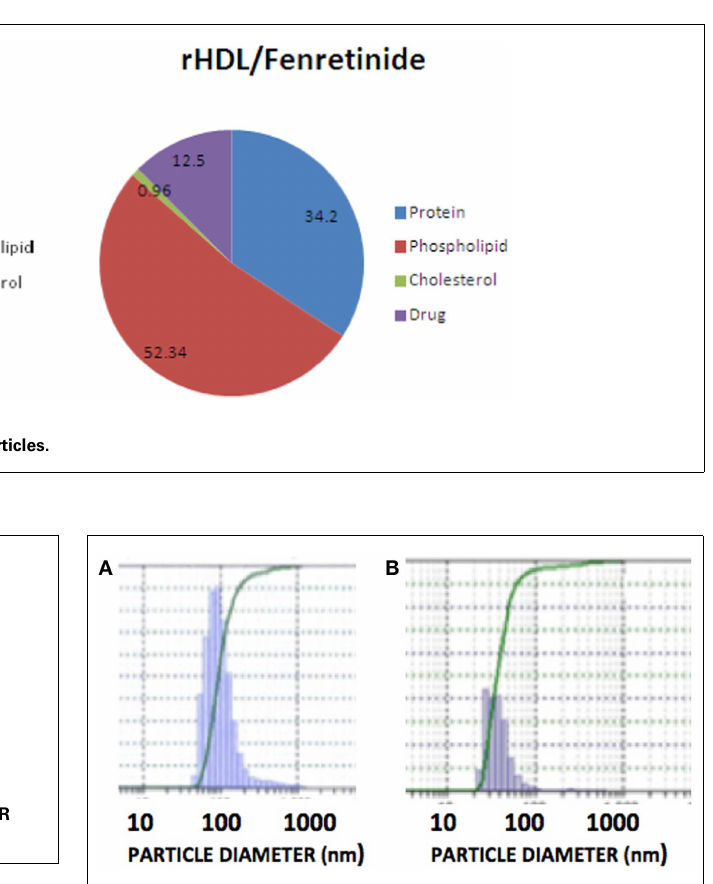
range of 22–101.2 nm with average diameter of 38.3 nm. AFM FIGURE 4 | Size distribution of rHDL/ATRA (A) and of rHDL/FR (B) nanoparticles with